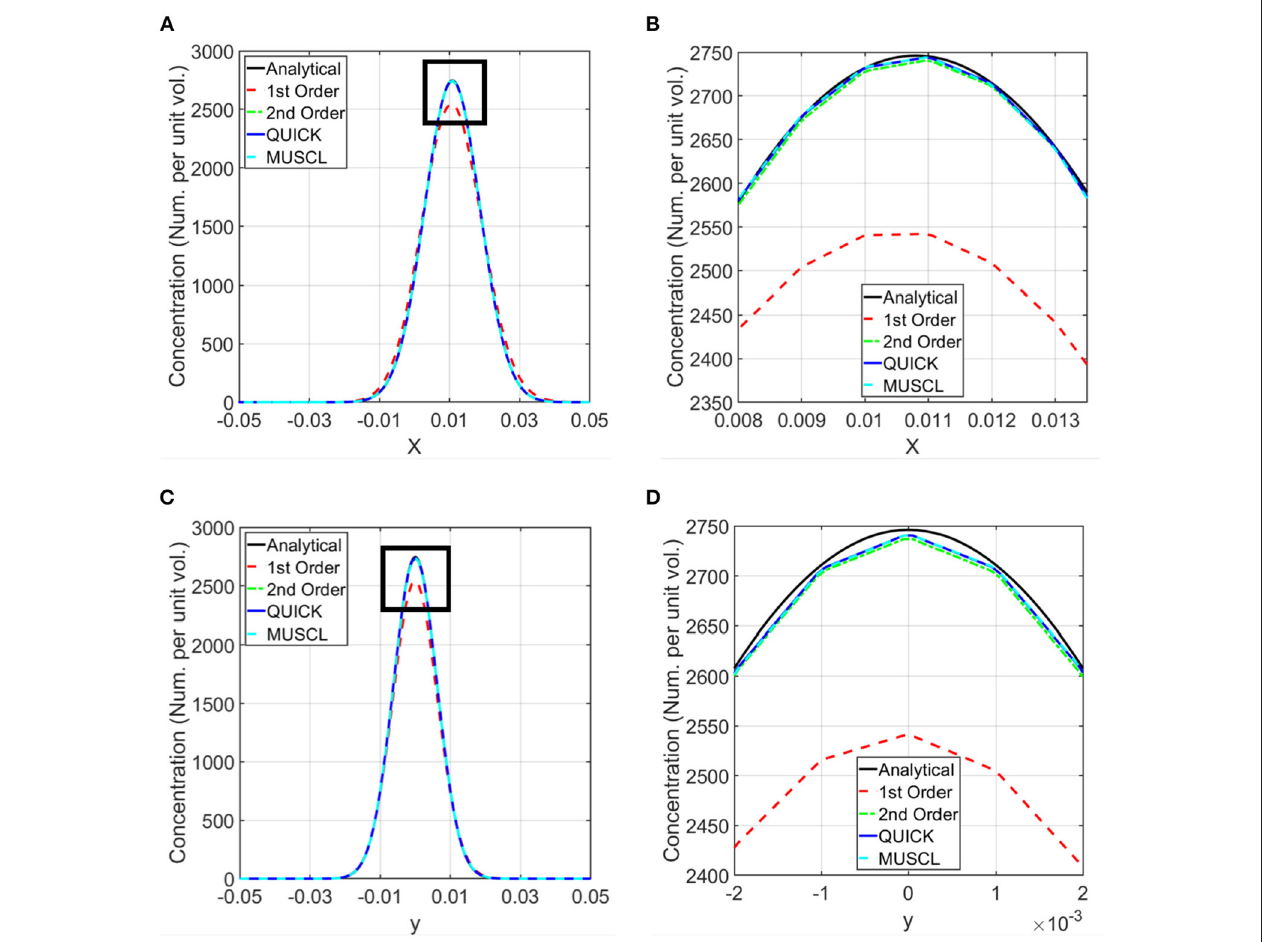
FIGURE 3 | Comparison of computed concentrations using different numerical schemes with the analytical solutions. Simulations were conducted using first order, second order upwind, second order QUICK, and third order MUSCL schemes for the discretization of the spatial derivatives in the transport equation (37–39). Computed concentrations are compared with the analytical results along the horizontal and vertical lines shown in Figure 2B . (A) Comparison of the concentration along the horizontal line. (B) Zoomed in view of the comparison in the rectangle marked in (A) . (C) Comparison of the concentration along the vertical line. (D) Zoomed in view of the concentration in the rectangle marked in (C)